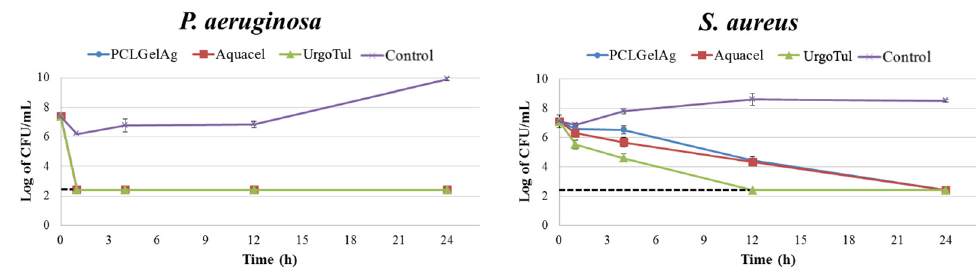
Figure 6. Time-kill curves of PCLGelAg, Aquacel, UrgoTul, and control dressings against P. aeru- ginosa and S. aureus . The black dashed lines indicate the limit of detection. and S. aureus . The black dashed lines indicate the limit of